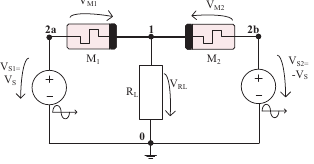
Fig. 15 : Schematic of the circuit with two memristors.